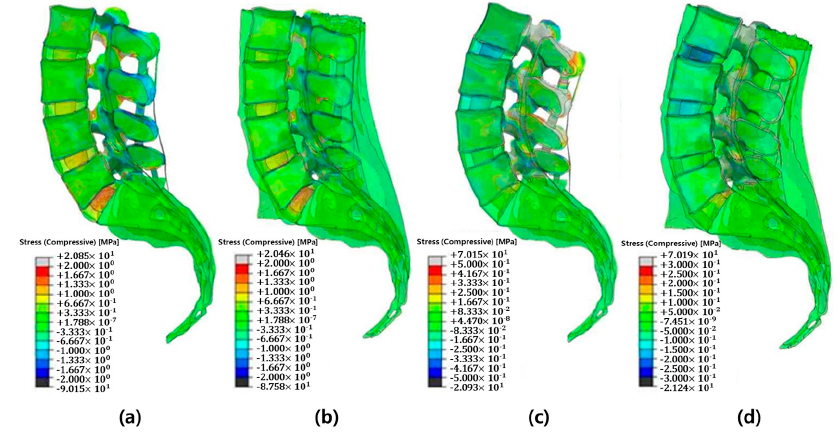
Table 4. Intradiscal pressure of various models with various elastic modulus of